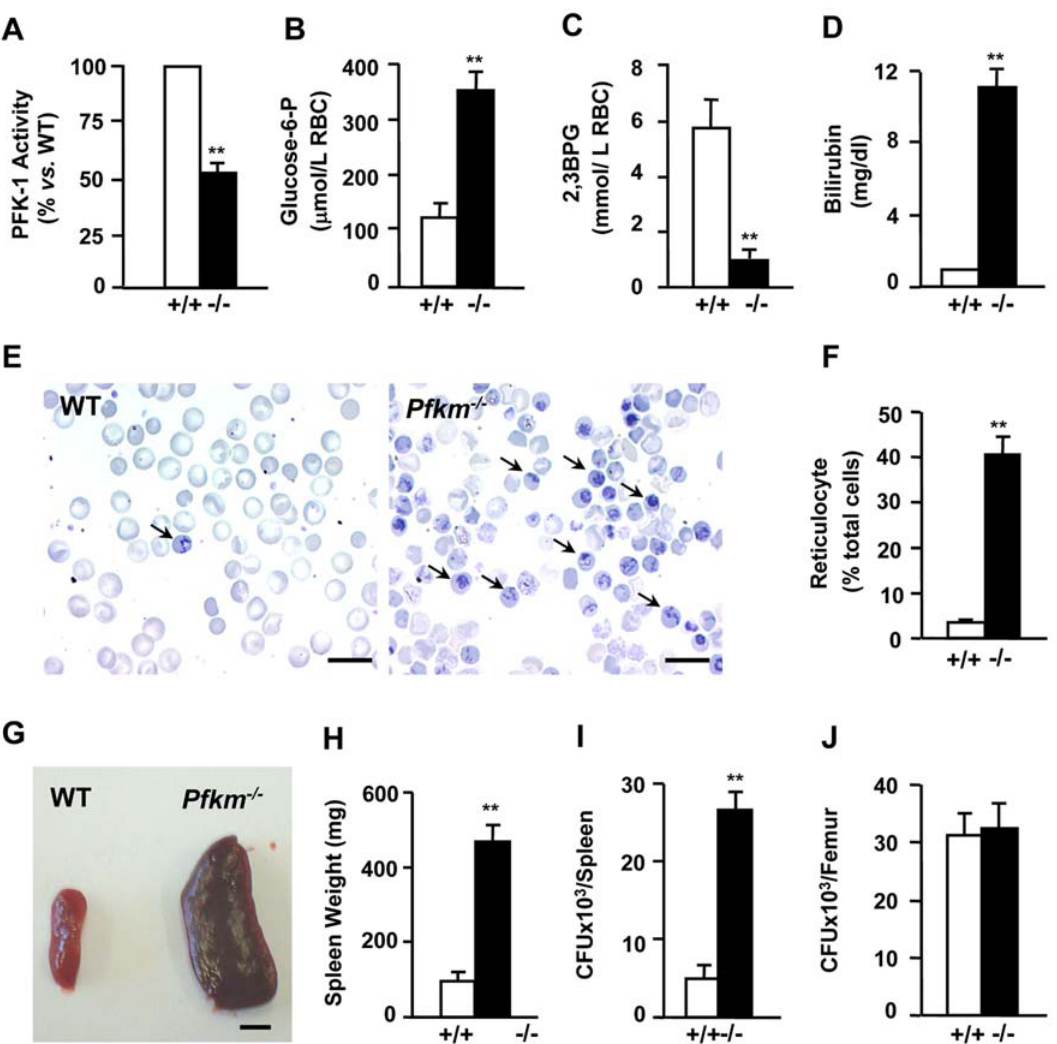
Figure 6. Reduction of erythrocyte PFK activity leads to hemolysis, reticulocytosis, and splenomegaly. (A) PFK activity was determined in blood cell lysates from wild-type ( + / + ) and Pfkm 2 / 2 ( 2 / 2 ) mice as indicated in Materials and Methods. (B,C) Glucose-6-phosphate (B) and 2,3- bisphosphoglycerate (2,3-BPG) (C) concentrations were determined in blood cell perchloric extracts as indicated in Materials andMethods. (D–F) Pfkm 2 / 2 show high serum bilirubin levels (D) and reticulocyte number (E,F). New methylene blue stained blood samples were extended on slices (E) and counted (F). Arrows indicate reticulocytes. Scale bar 15 m m. (G,H) Splenomegaly in Pfkm 2 / 2 mice. A high increase in spleen size (G) and weight (H) was observed. Scale bar 5 mm. (I,J) Hematopoietic precursors in cultured cells from spleen (I) and femur (J) from wild-type ( + / + ) and Pfkm 2 / 2 ( 2 / 2 ) mice. Results are mean 6 SEM of five to eight mice per group. ** P , 0.01 vs. wild-type.